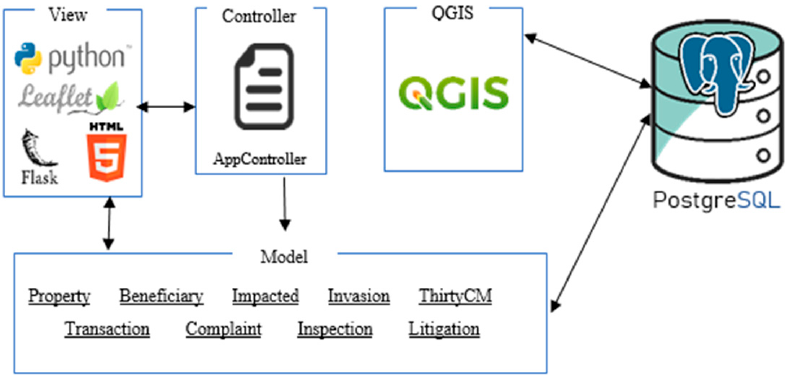
Figure 1. Tool Architecture diagram.